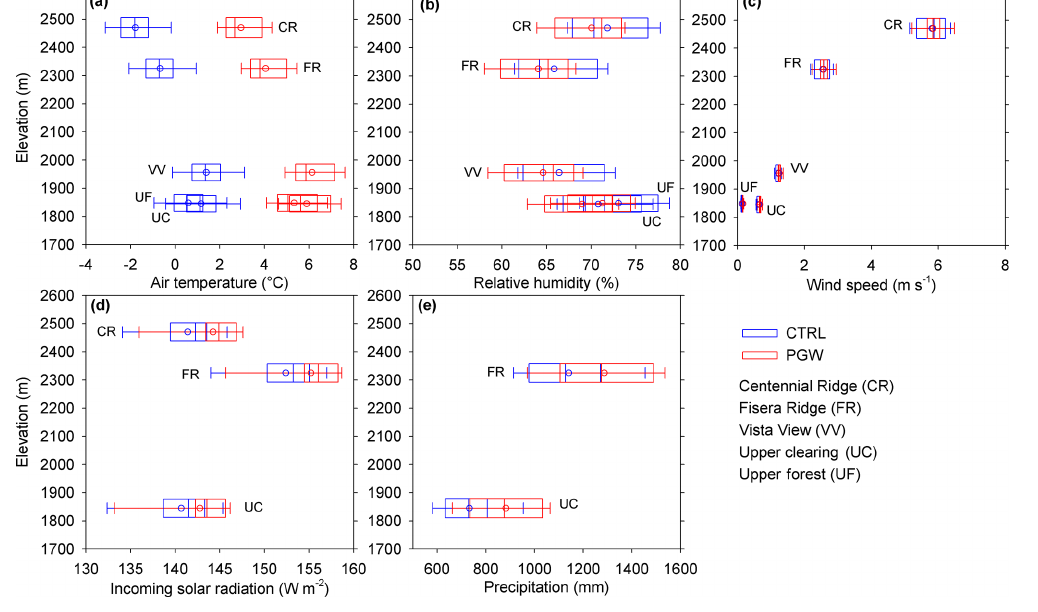
Figure 6. Boxplots of the bias-corrected WRF CTRL and PGW near-surface meteorology for MCRB station sites. (a) Air temperature, (b) relative humidity, (c) wind speed, (d) solar irradiance, and (e) precipitation. Note that the accumulation over the water year is used for precipitation, and the average value over the water year is presented for the other variables. The vertical line within the box is the median value of the 8 water year data, the box is the interquartile range ( Q 1 : 25% to Q 3 : 75%) of the 8 water year data, the whiskers are the minimum and maximum, and the circle is the mean value of the 8 water year data. Table 5. Simulated basin-scale mean annual air temperature, relative humidity, wind speed, mean annual water balance fluxes, mean annual radiation fluxes to snow cover, mean seasonal cumulative snowmelt, peak snow accumulation, snow-cover duration, and snowmelt rate for WRF CTRL and PGW. CTRL PGW Change: